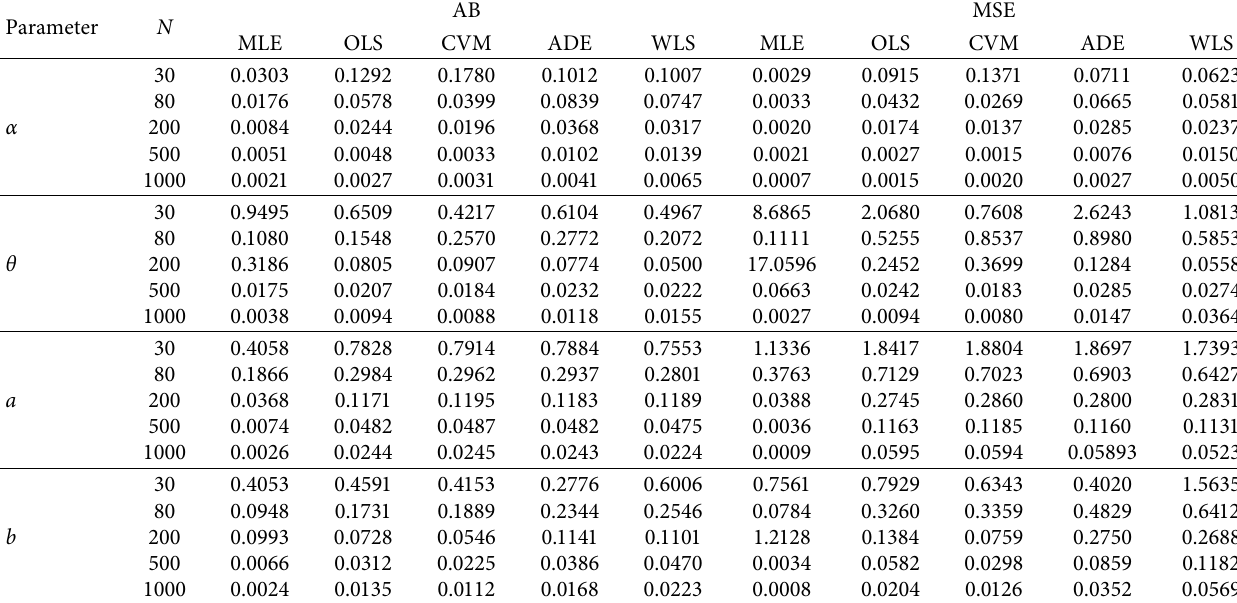
Table 3: Results of simulations for ( α , θ ,a,b ) � ( 0 . 1 , 0 . 8 , 2 . 5 , 3 . 0 ) .